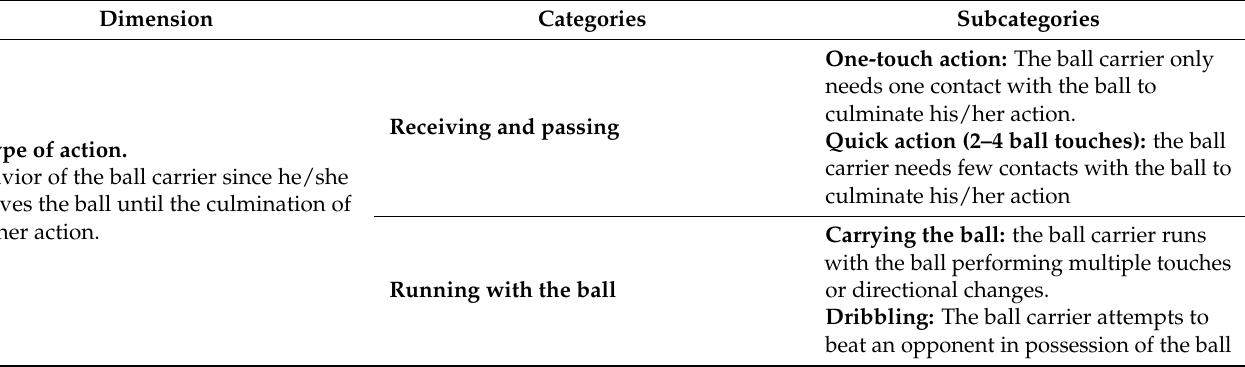
Table 2. Operational definitions for the dimensions included in the moment of processing the ball. Dimension